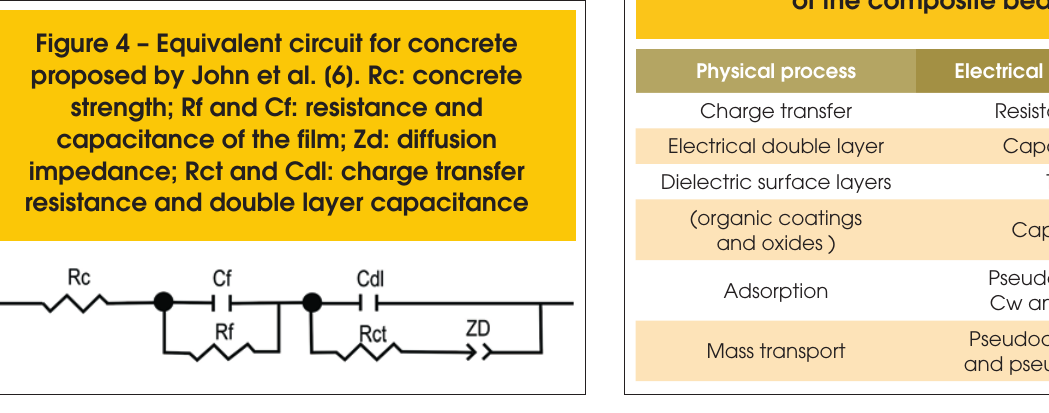
Figure 4 – Equivalent circuit for